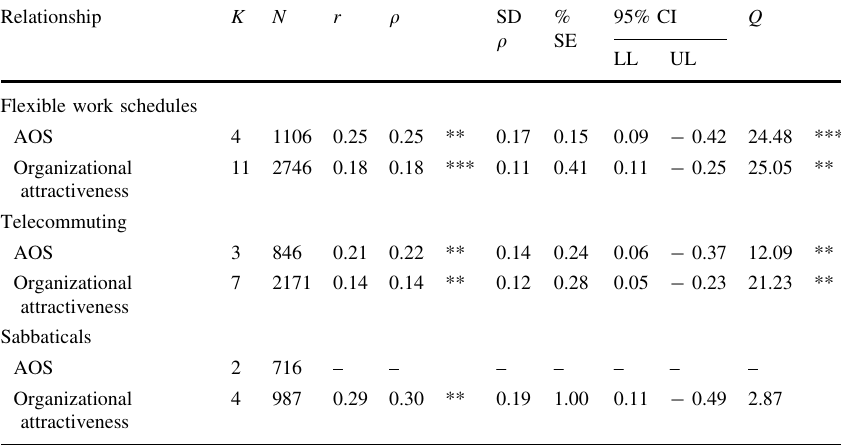
Table 2 Meta-analytic results for bivariate relationships between FWPs, mediators and external out- come variables